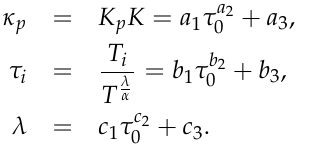
Table 1. FOPID tuning for servo and regulatory control operation, M t